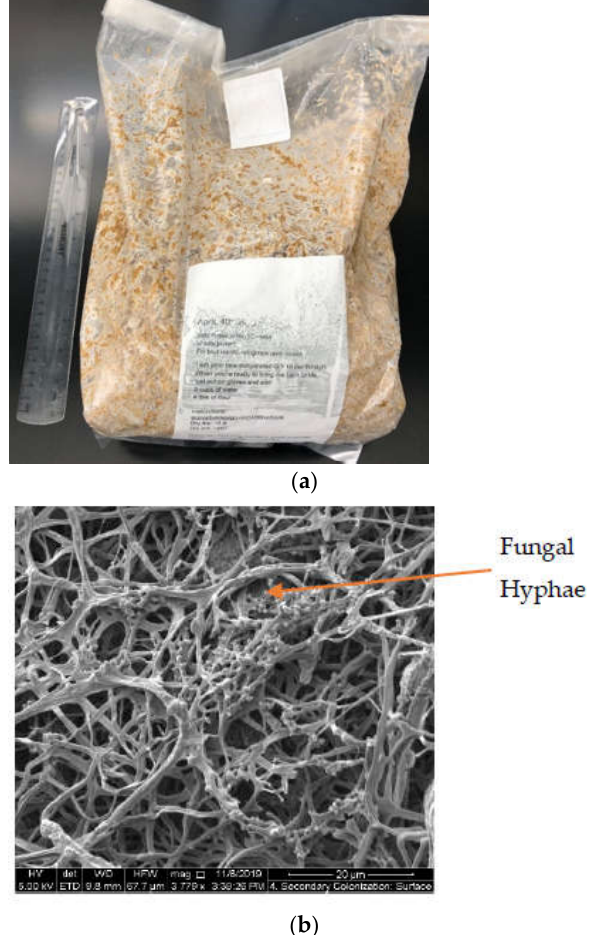
Figure 3. Biomass–fungi material after primary colonization: ( a ) primary colonized material in filter patch bag; ( b ) scanning electron microscopy (SEM) image of the surface of a sample after colonization. Scale bar is 20 µm.